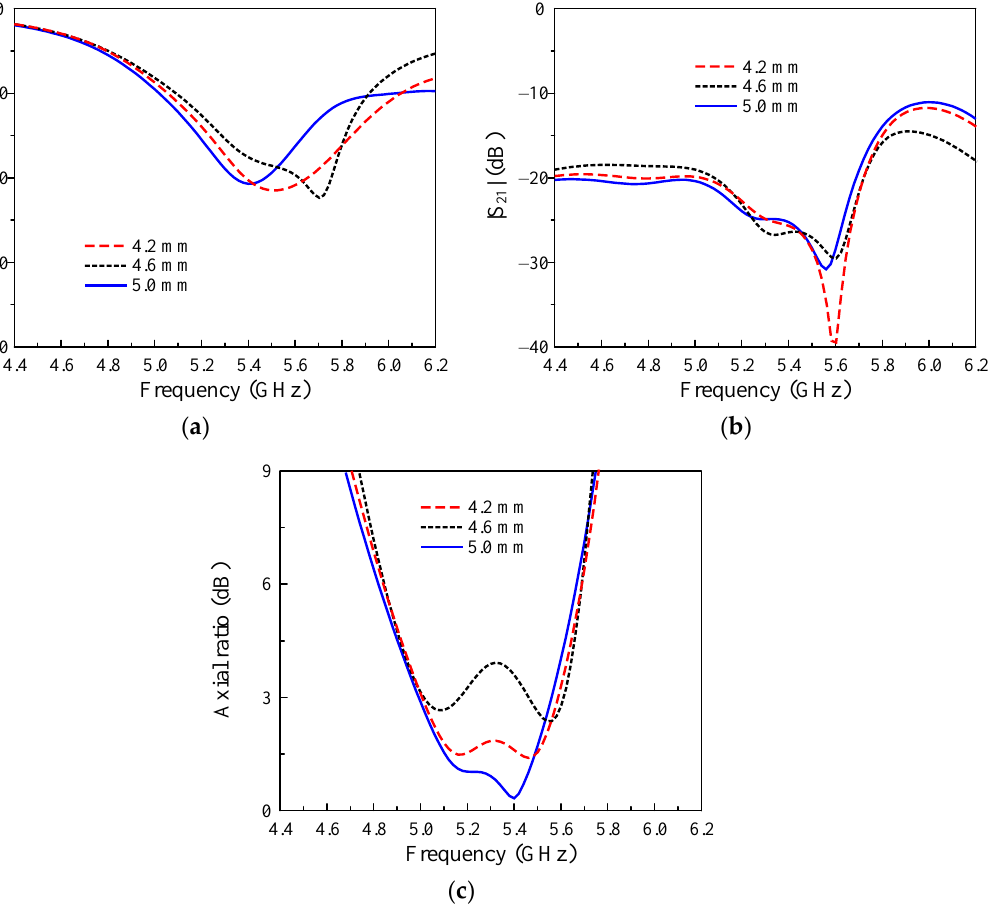
Figure 9. Simulated performance of the proposed MIMO antenna with different values of a . ( a ) Re- flection coefficient (|S 11 |), ( b ) transmission coefficient (|S 21 |), and ( c ) axial ratio (AR).